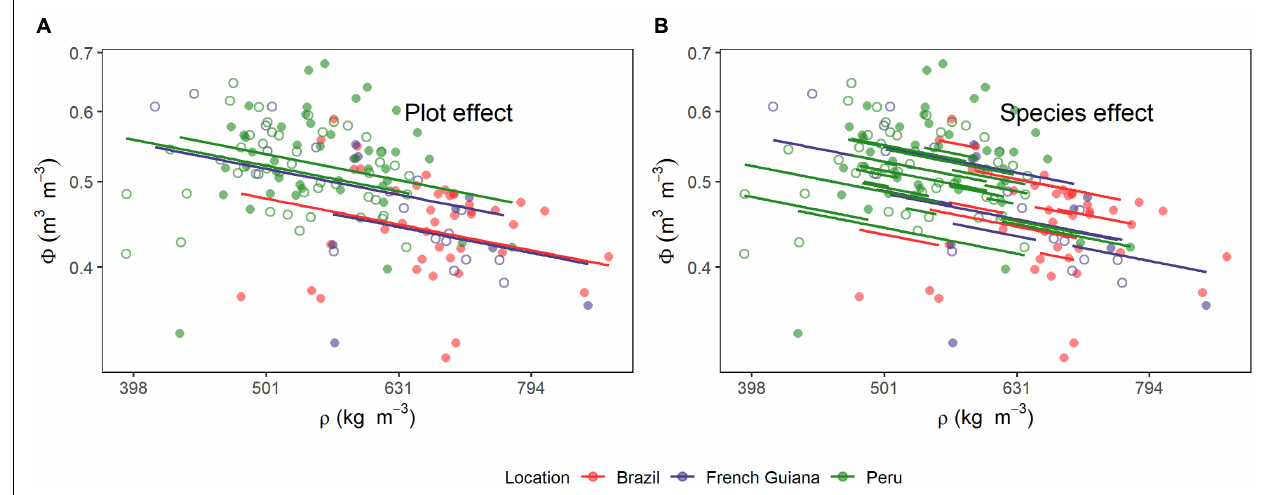
FIGURE 5 | Relationships between wood density ( ρ ) and stem volumetric water content ( (cid:56) ). Lines are predicted estimates of mixed models for the (A) species and (B) plot effects (Equation 6). Open and closed circles represent the plots within each location.